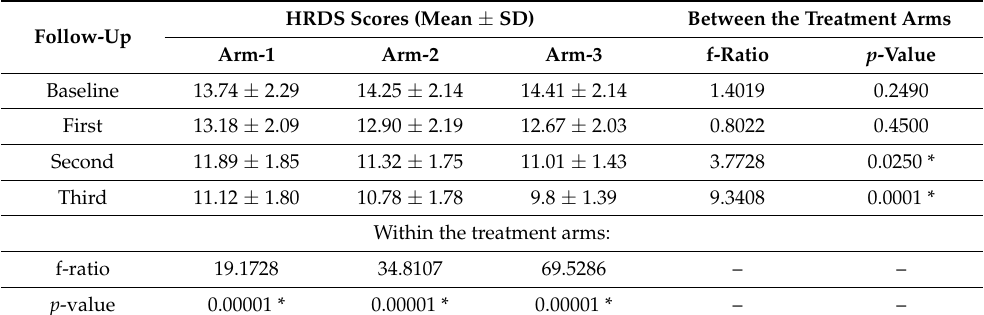
Table 3. Comparison of HRDS scores in different treatment arms from baseline to first, second and third follow-ups